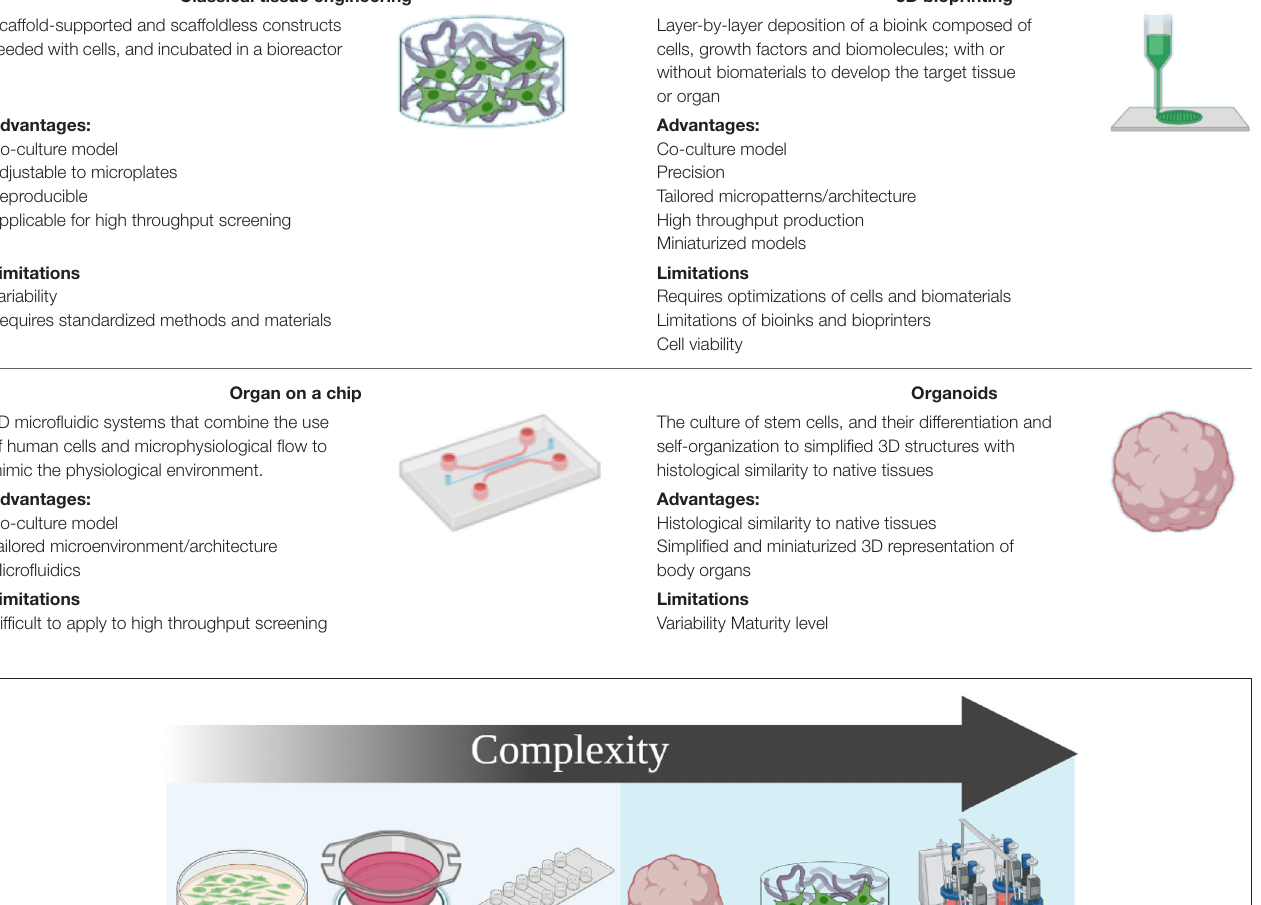
TABLE 1 | Approaches for the development of 3D drug screening systems, their advantages, and limitations (16). Classical tissue